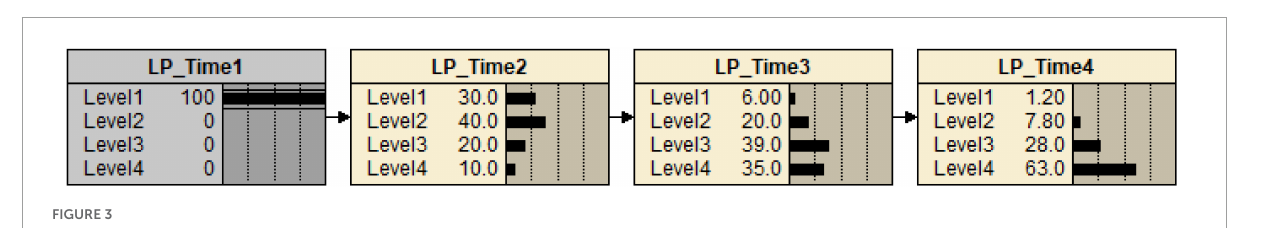
FIGURE2 Initial probability matrix and transition probability matrices.